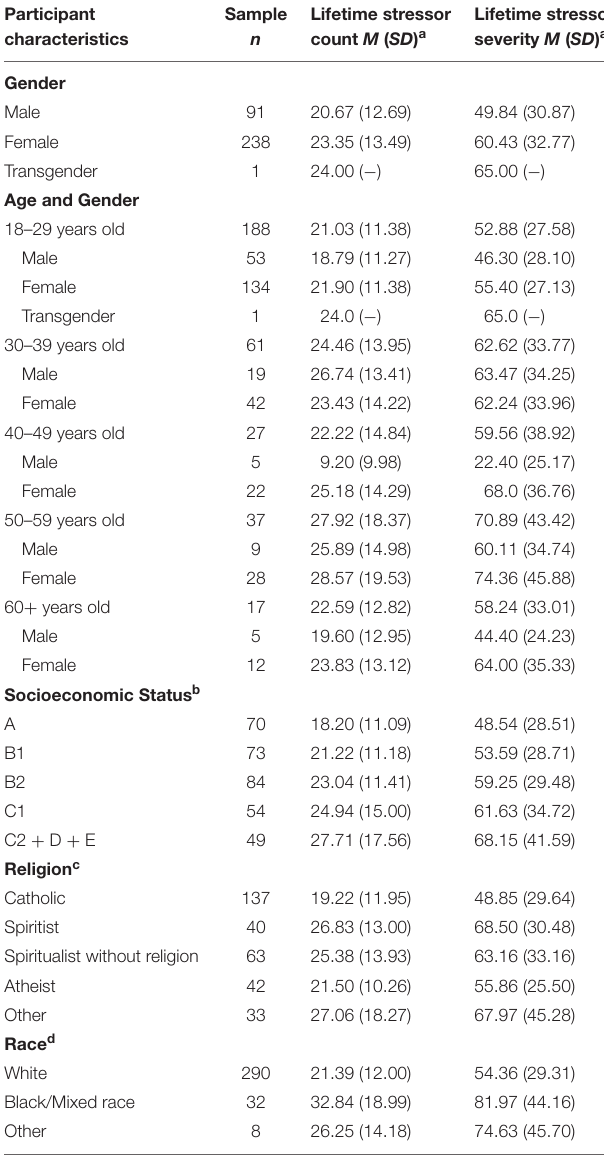
TABLE 1 | Lifetime stressor count and lifetime stressor severity according to participants’ demographic